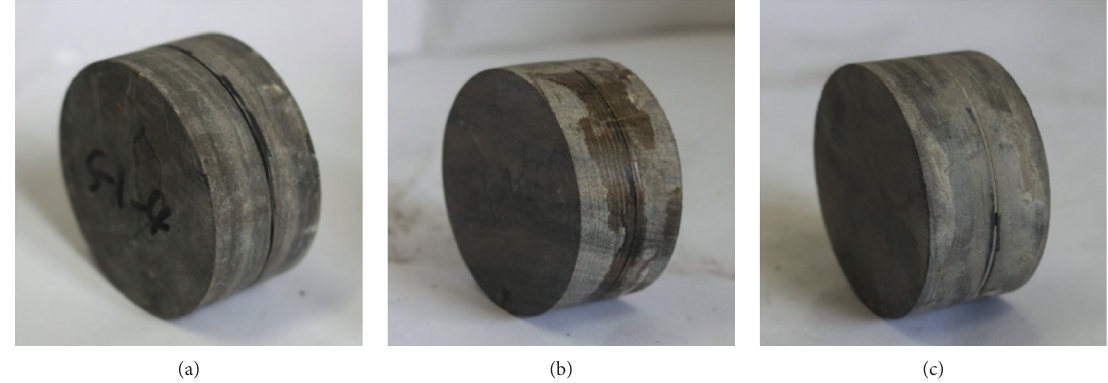
Figure 1: Specimens: (a) fracture specimen, (b) modified epoxy resin grouting, and (c) cement grouting.